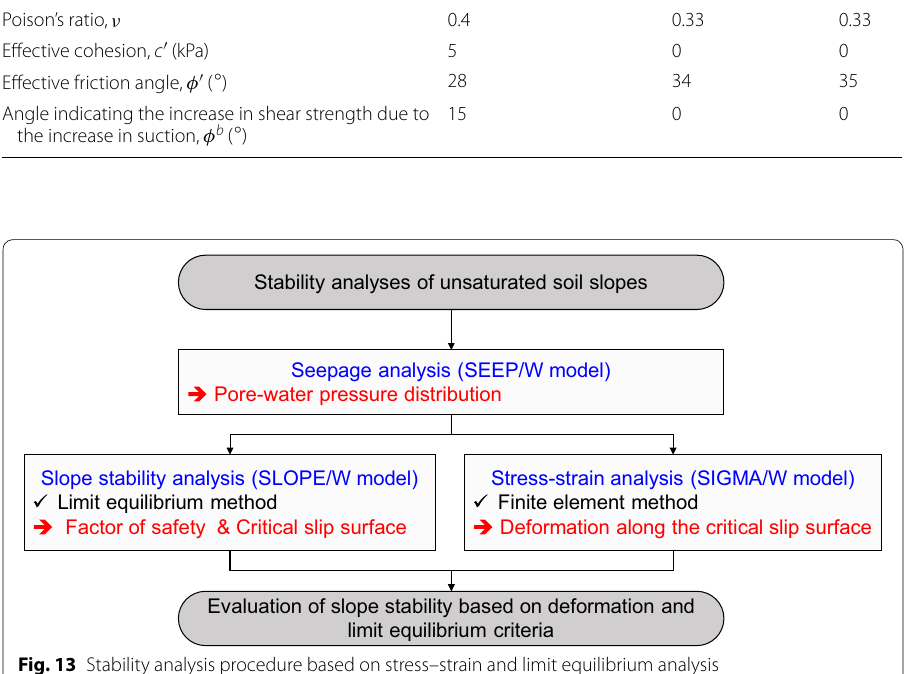
Fig. 13 Stability analysis procedure based on stress–strain and limit equilibrium